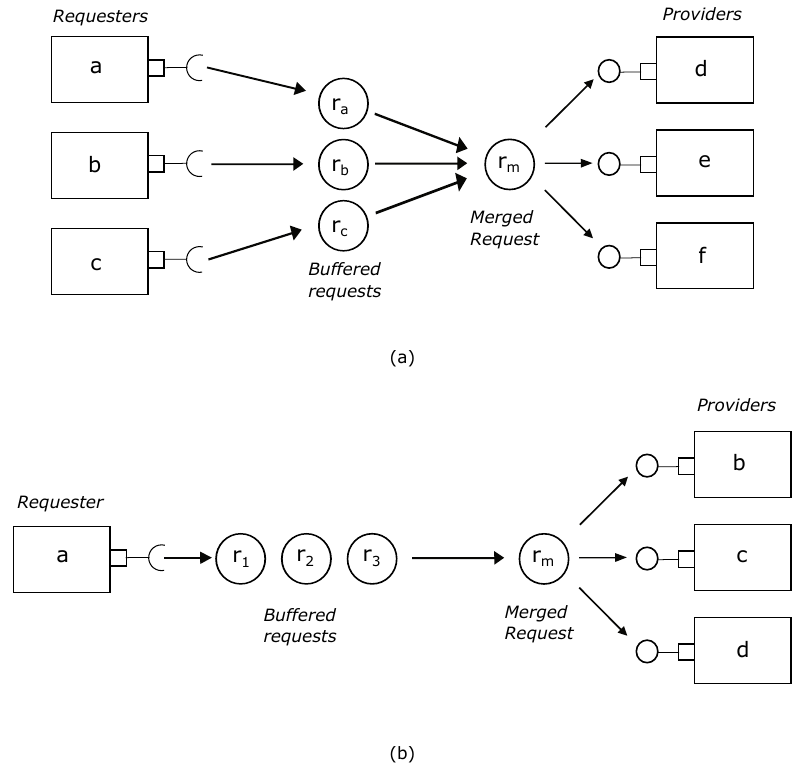
Figure 6. Merging requests using buffers: ( a ) Storing requests from multiple requesters in single-copy request buffers. ( b ) Storing subsequent requests from a requester in a FIFO request